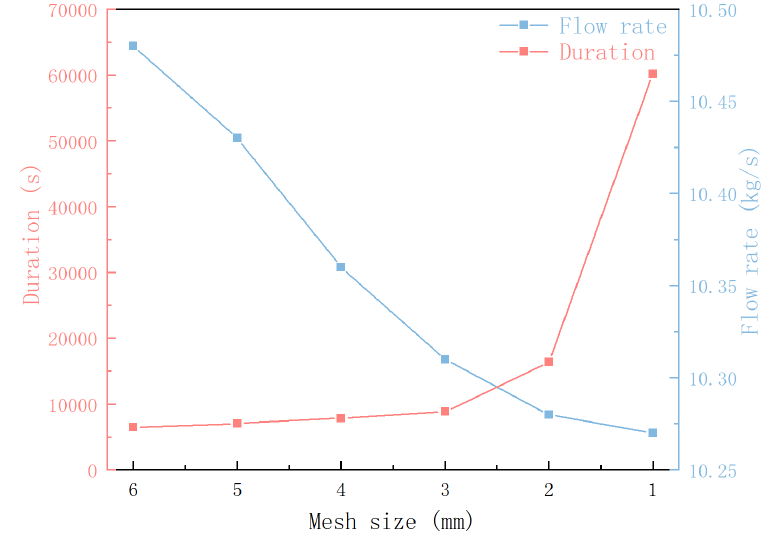
Figure 2. Mesh size and flow rate and time consumption.